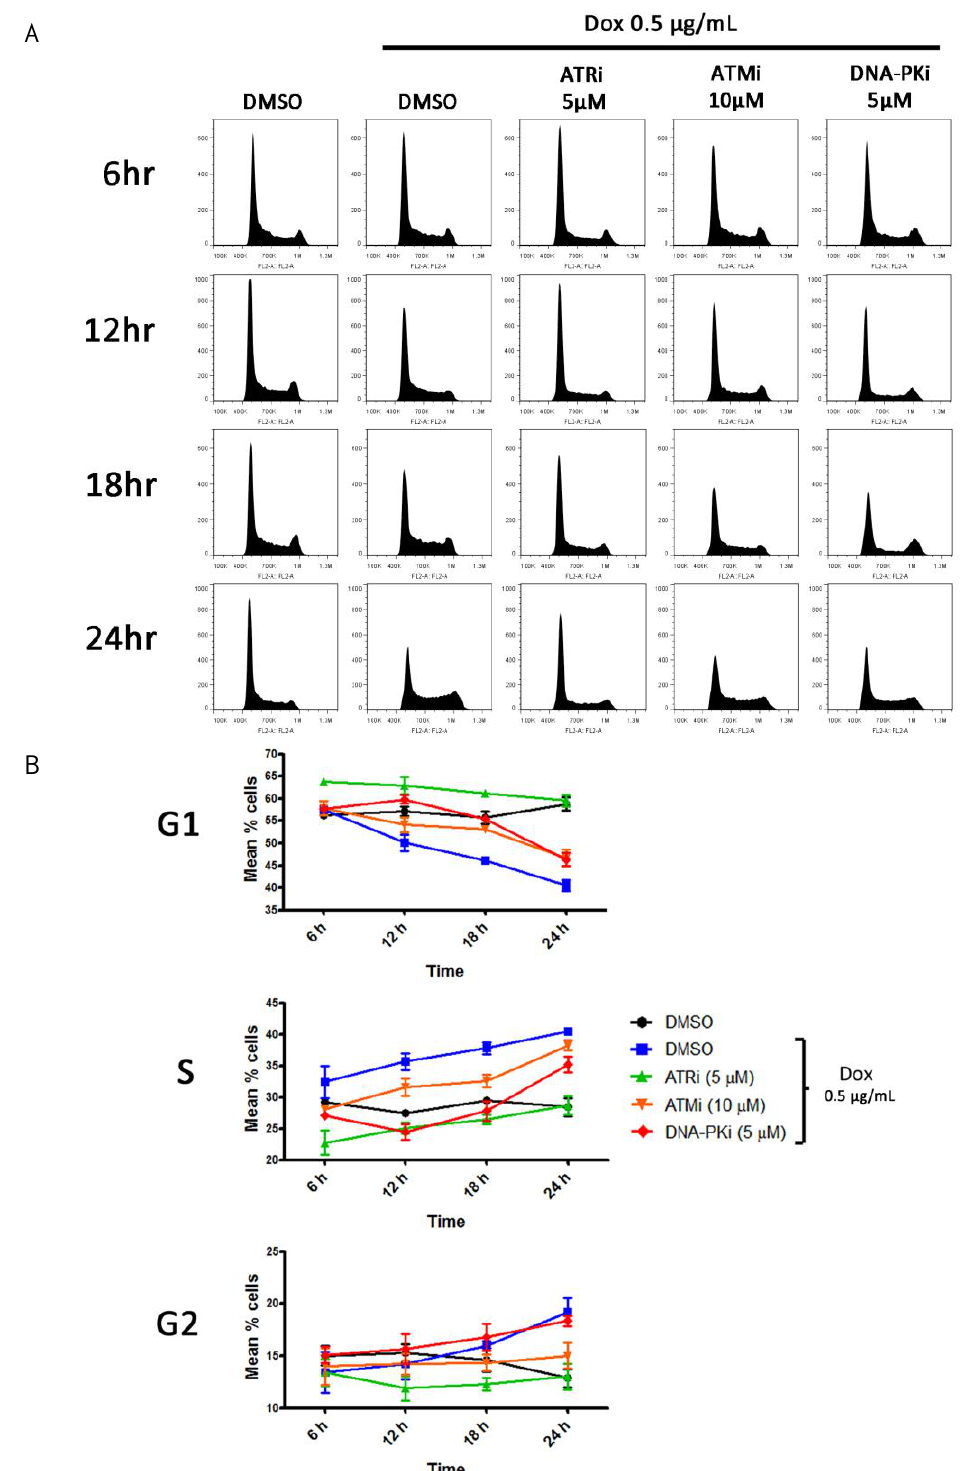
Figure 5. Cell cycle changes during lytic replication of KSHV. ( A ) Representative cell cycle profiles following PI staining of TRE-BCBL-1-RTA cells after addition of doxycycline in the presence and absence of DDR kinase inhibitors; ( B ) Percentage of TRE-BCBL-1-RTA cells in different phases of the cell cycle at 4 different time points following addition of doxycycline in the presence and absence of DDR kinase inhibitors. Each data point represents the mean of three independent experiments while the error bars represent the standard error of the mean